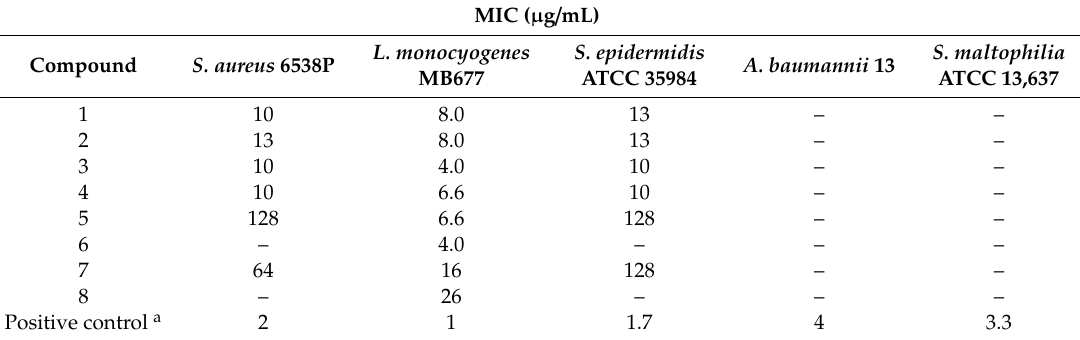
Table 2. Antimicrobial activity expressed as MIC values for the pure Compounds 1–8 towards a panel of human